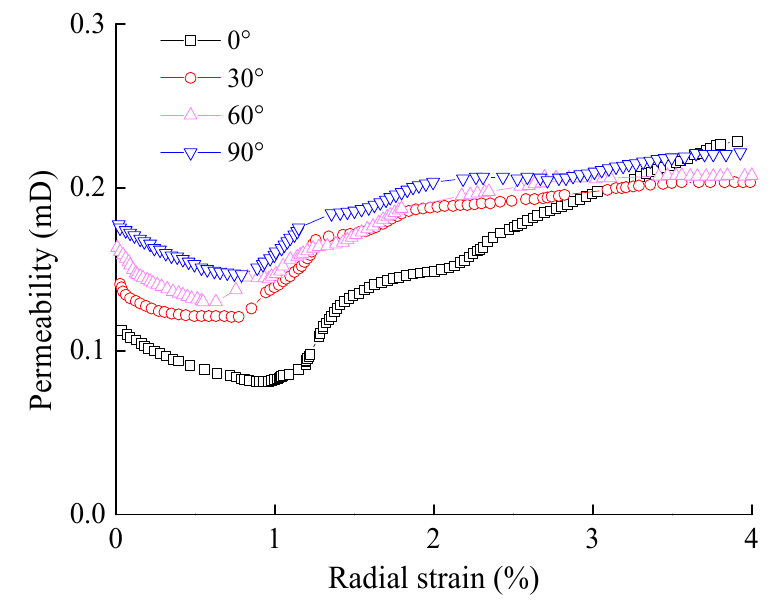
Figure 7. Relationship of permeability and radial strain.